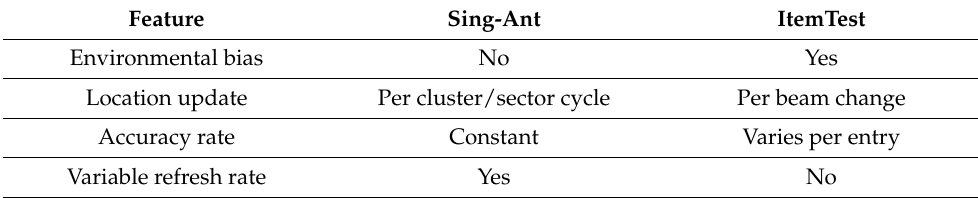
Table 6. System comparison of ItemTest and